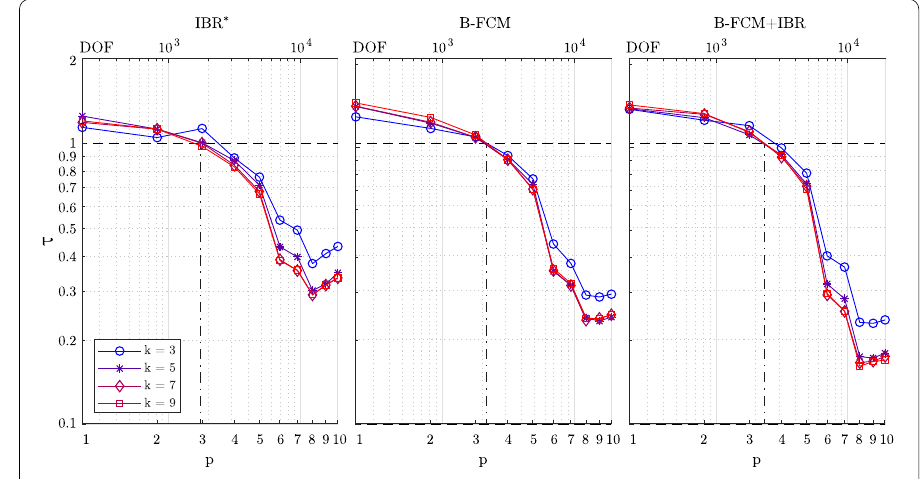
Fig. 25 τ -Values of the investigated methods. The depicted curves are obtained by a discretization of = 10 of the problem depicted in Fig. 21 n C